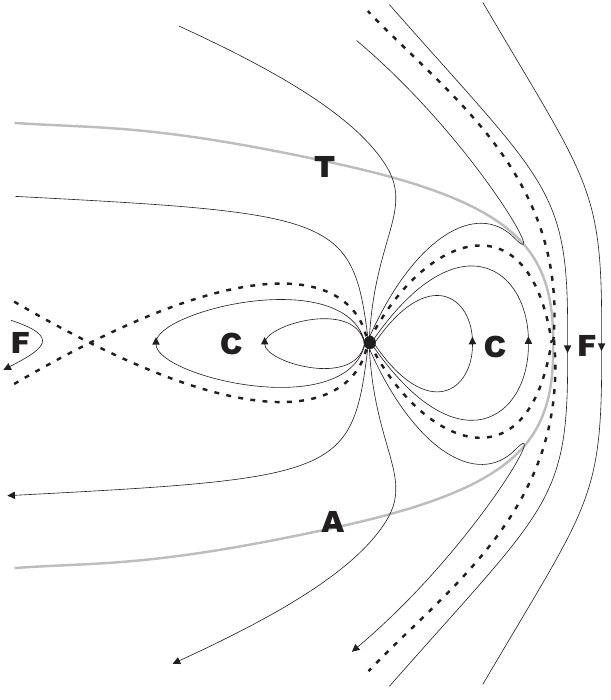
Fig. 2. The four topologically different magnetic field regions in the magnetosphere during southward IMF. T stands for toward the Earth, A for away, C for closed and F for free field lines. The figure is drawn for southward IMF, and under these conditions the four re- gions are seen to meet at the magnetopause and magnetotail recon- nection sites. Figure 3 will show that the separator drapes around the Earth along the flanks of the magnetopause. Compare also with Figs. 1a, b, 2a and 4a in Park et al.